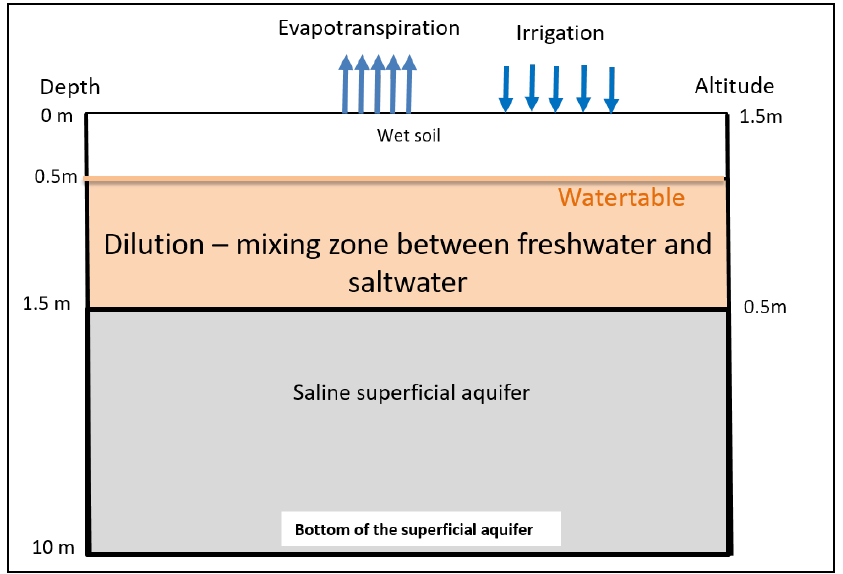
Figure 9. Conceptual model of the water and saline functioning of the soil–aquifer system in the irrigated plots of the DFS during rice growing.